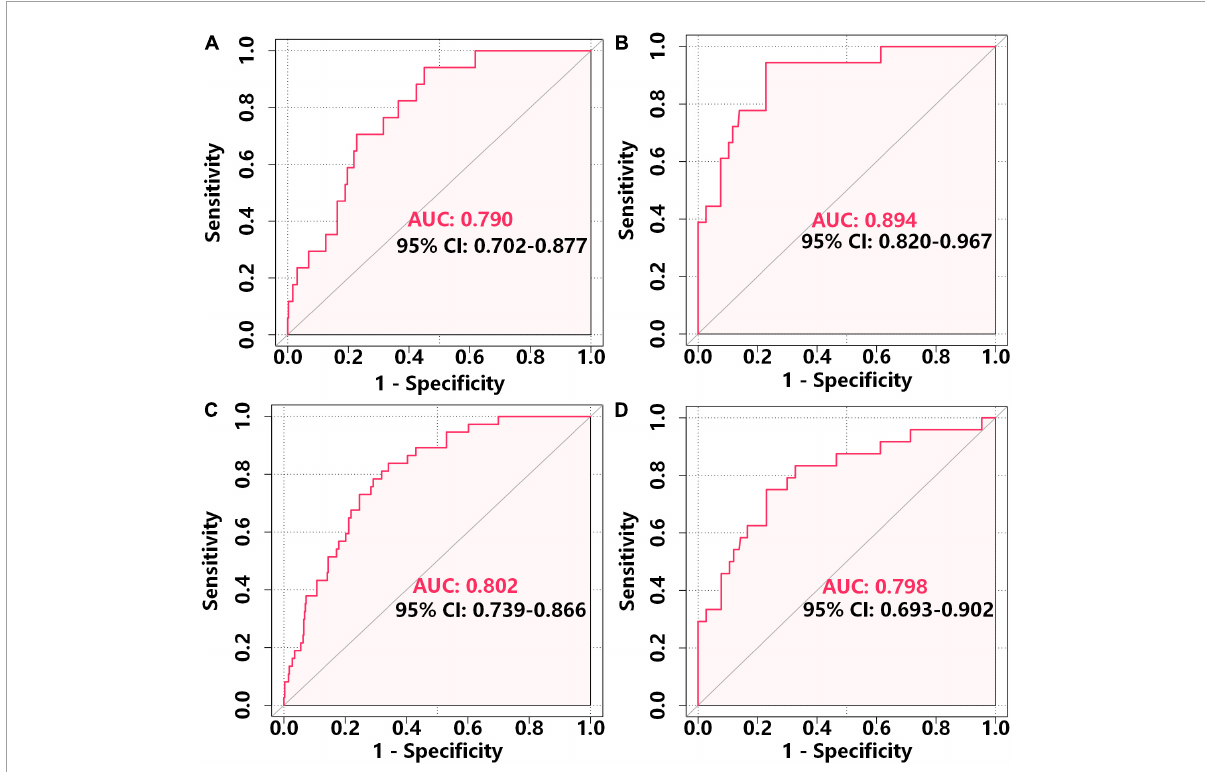
FIGURE4 ROC analysis of the accuracy of the nomogram in predicting 1-year MACE-free survival in the development cohort (A) and external validation cohort (B) and 2-year MACE-free survival in the development cohort (C) and external validation cohort (D)